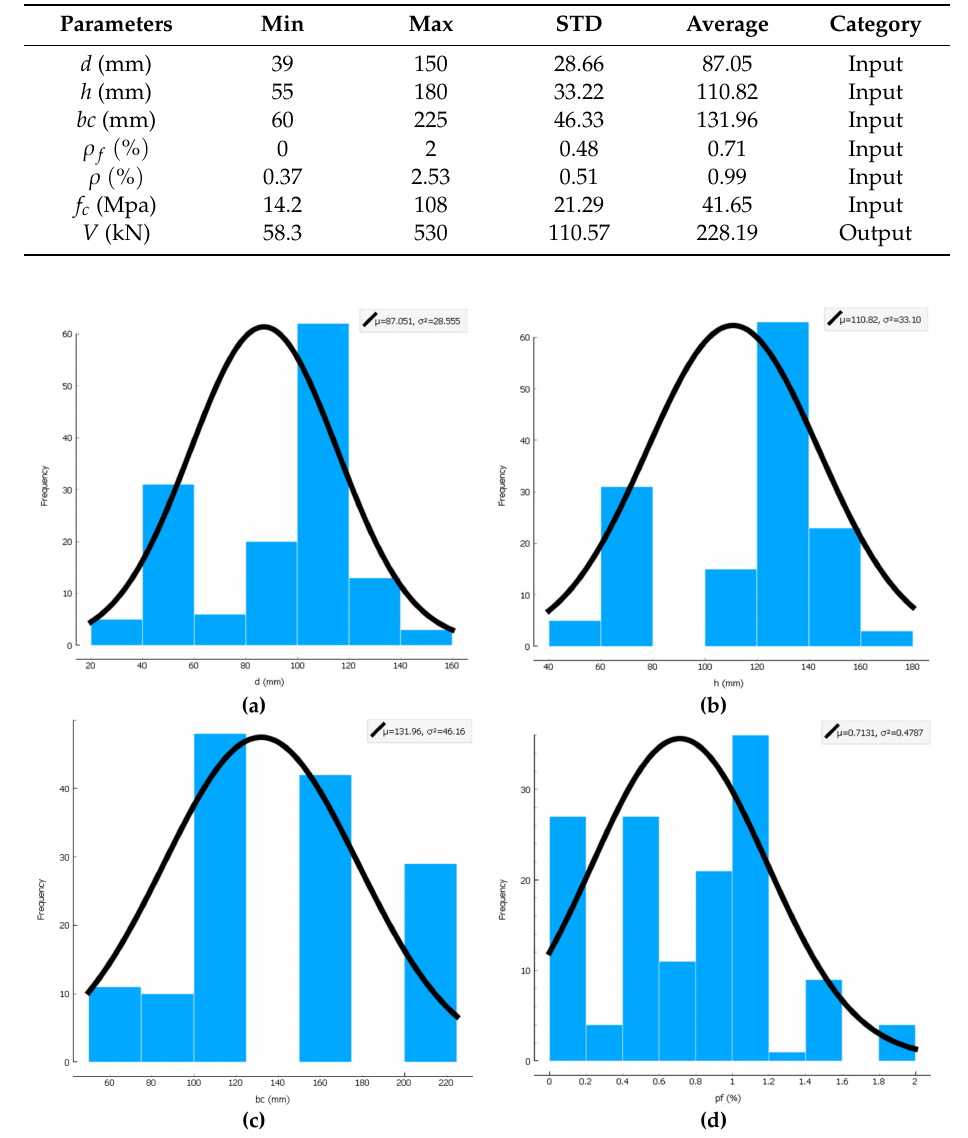
Table 1. The statistical descriptions of the parameters to predict punching shear strength.